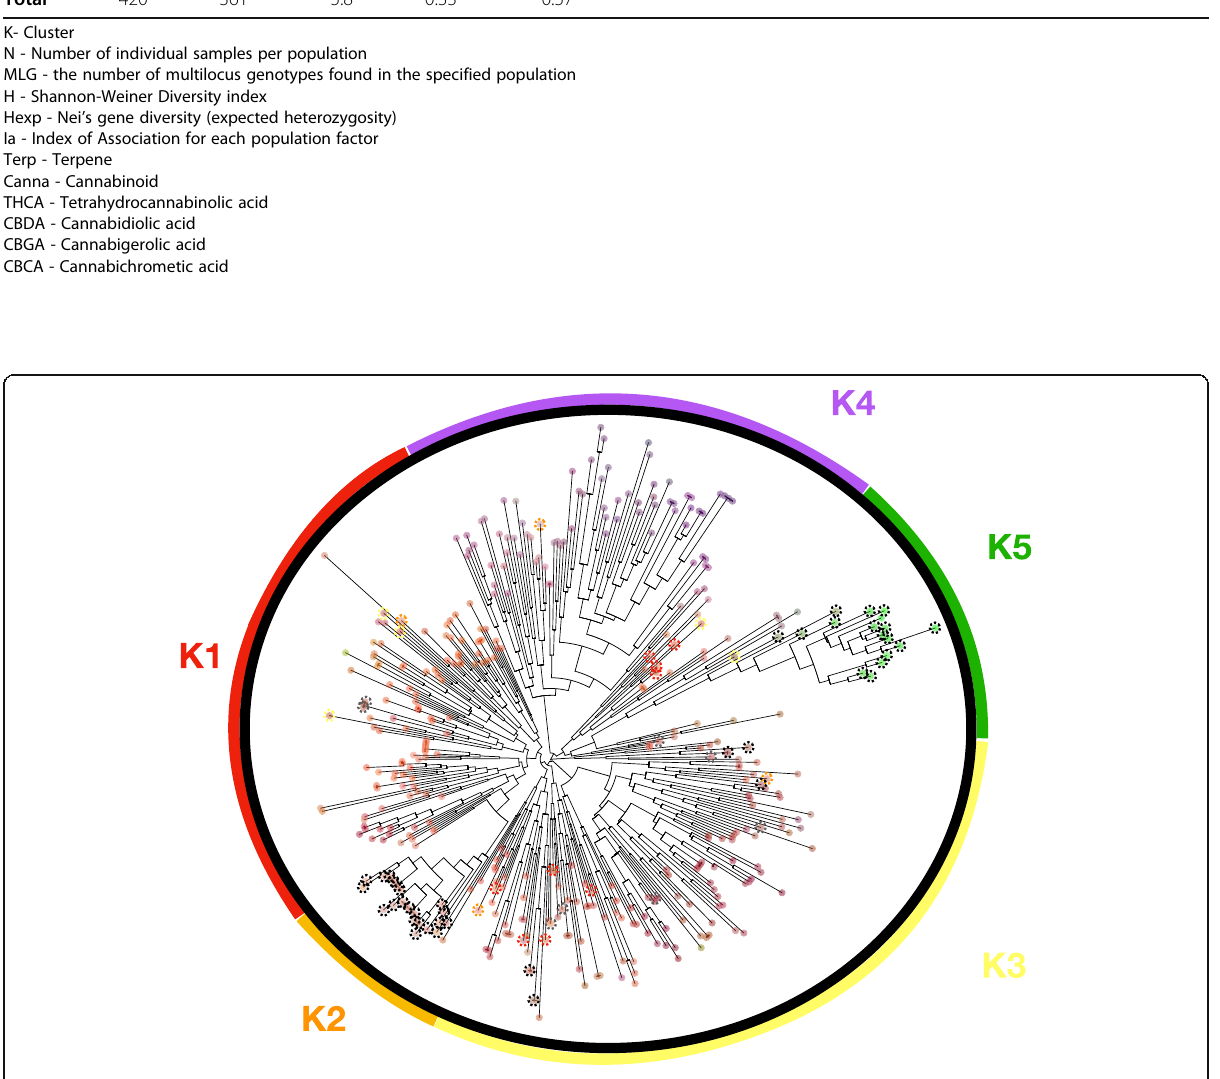
Fig. 1 Neighbour-joining tree. Showing the relative phylogenetic location of the 420 cannabis accessions typed at 23 single nucleotide polymorphisms (SNP). Discriminant analysis of principal component (DAPC) clusters are shown with K1-K5 represented by different colors. K1-K4 are resin type cannabis and K5 is the fiber type cannabis or hemp. Colored dotted circles highlight individuals assigned differently between the neighbor-joining tree and DAPC clusters. Type-III plants are shown with a dotted black circle and type-II plants are shown with dotted grey